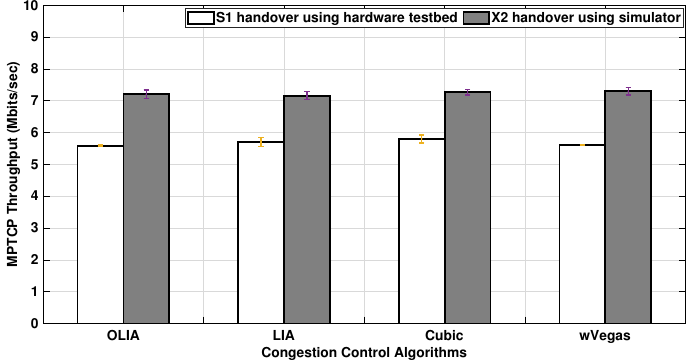
Figure 15. Setup 1 MPTCP throughput with handover for different congestion control